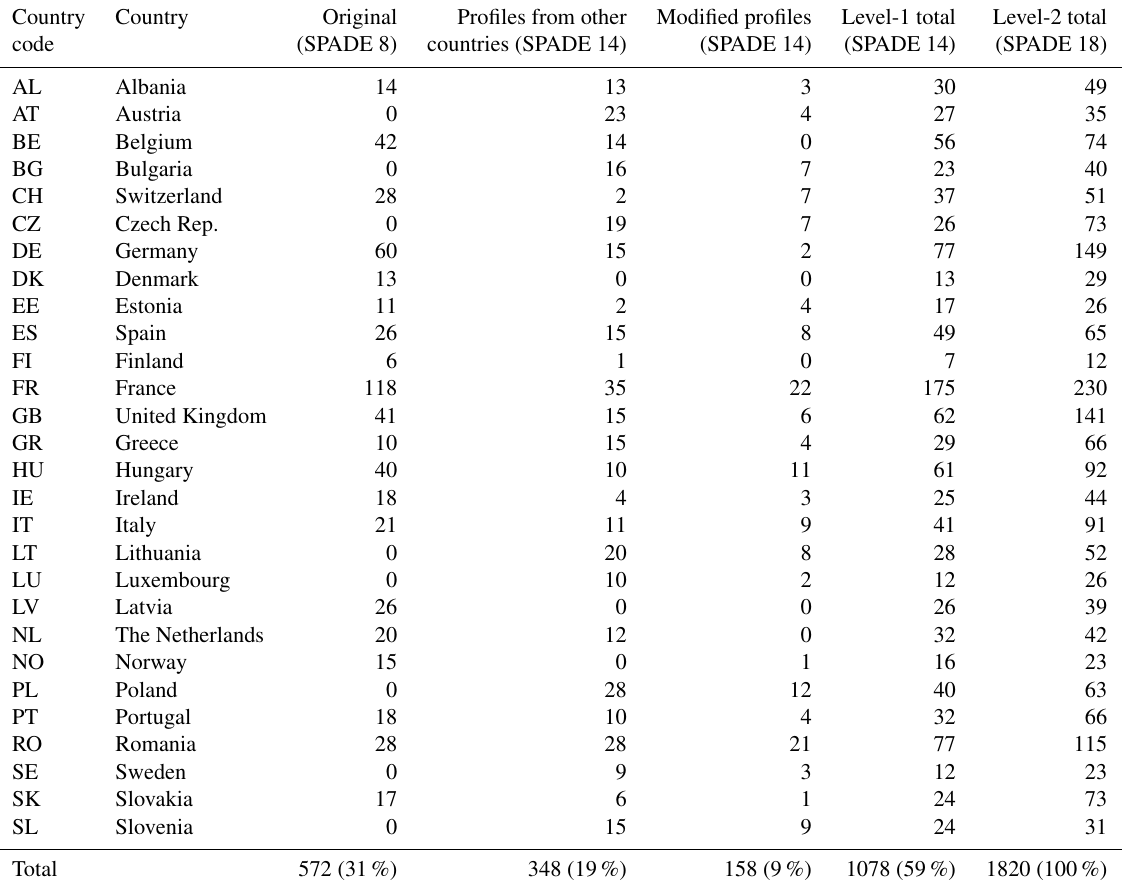
Table 2. The origin of SPADE data at the national level. “Original” shows the soil profiles for which the stakeholders originally provided data, “Profiles from other countries” show the soil profiles for which data were copied and pasted from a similar country, “Modified profiles” show the soil profiles to which slight adjustments were made, “Level-1 total” shows the total number of dominating soil profiles, which are available in the current database (SPADE 14), and “Level-2 total” shows the total number of profiles when associated soil types were included. The datasets for associated soils will be available when the level-2 database (SPADE 18) is fully